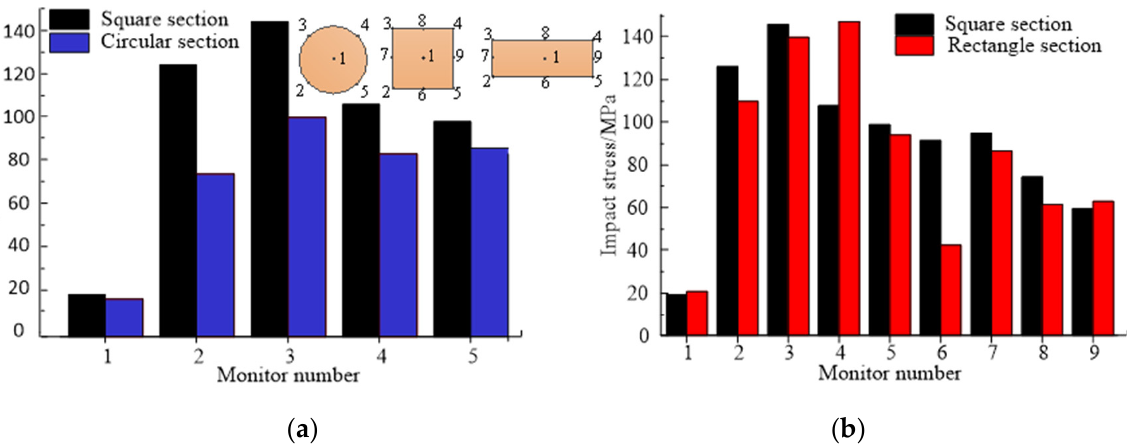
Figure 5. Stress distributions at different positions of impact section: ( a ) comparison of square and circular hammers; ( b ) comparison of square and rectangular hammers.